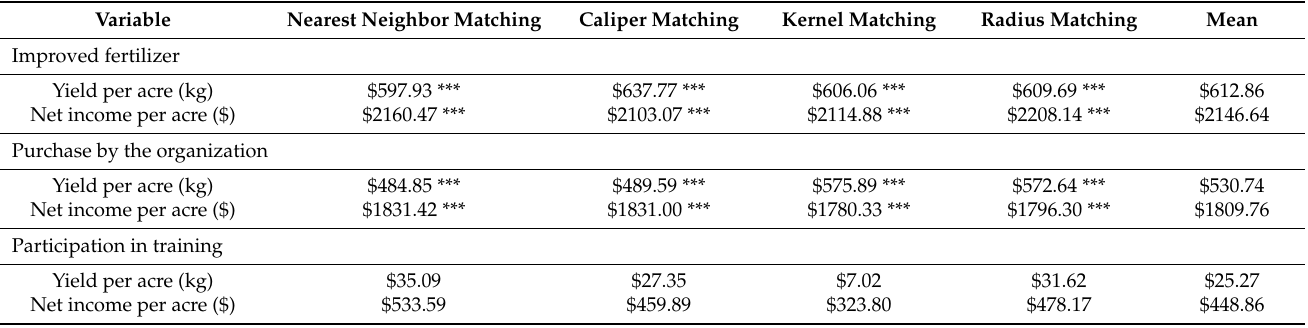
Table 3. Average treatment effect of yield per acre and net income per acre based on the PSM model.